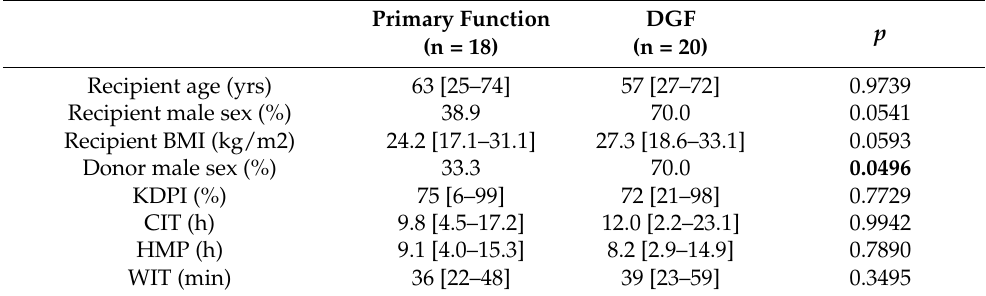
Table 2. Recipient and donor characteristics, as well as surgical details, according to initial graft function. Primary Function (n = 18)